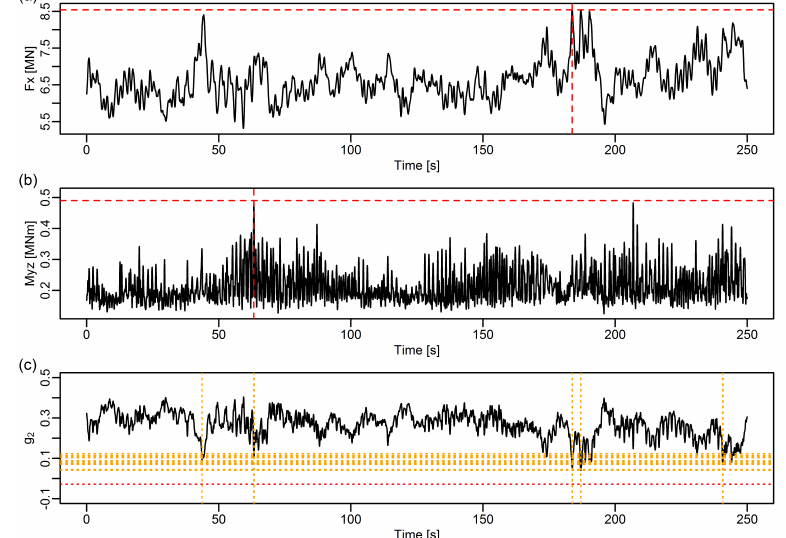
Figure 1. Illustration of the difference between Pareto-optimal loads and the standard approach for the bottom joint in the OC4 jacket support structure, at rated wind speed. ( a ) axial force. ( b ) total bending moment. The broken red lines indicate the locations and values of the univariate maxima. ( c ) limit state function for combined bending and compression (Equation (5)). The broken red line indicates the value for the conservative combination of univariate maxima. The dotted orange lines indicate the locations and values at the Pareto-optimal points. Note that only a small part of the total time series has been shown, for the purposes of better visualization.